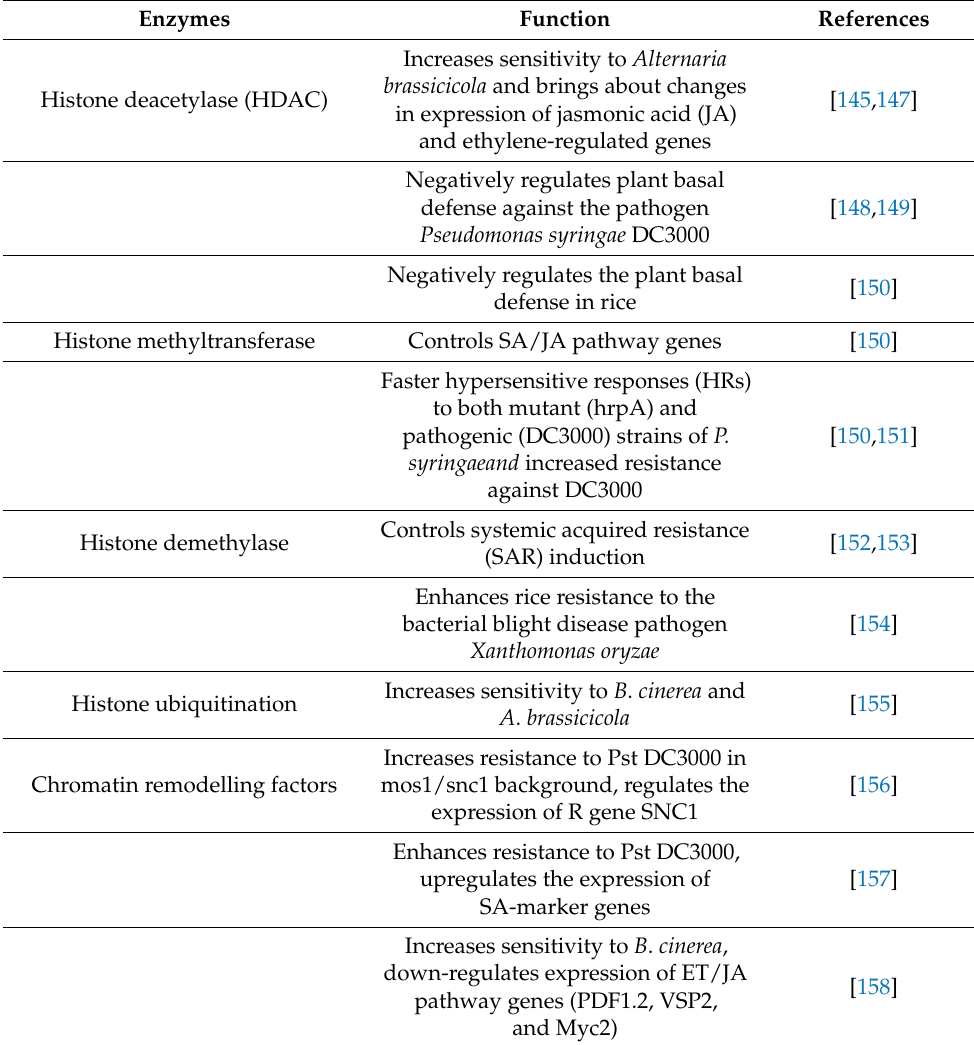
Table 2. Shows various histone PTM modifying enzymes conferring sensitivity or resistance to the hosts of pathogens as a result of their